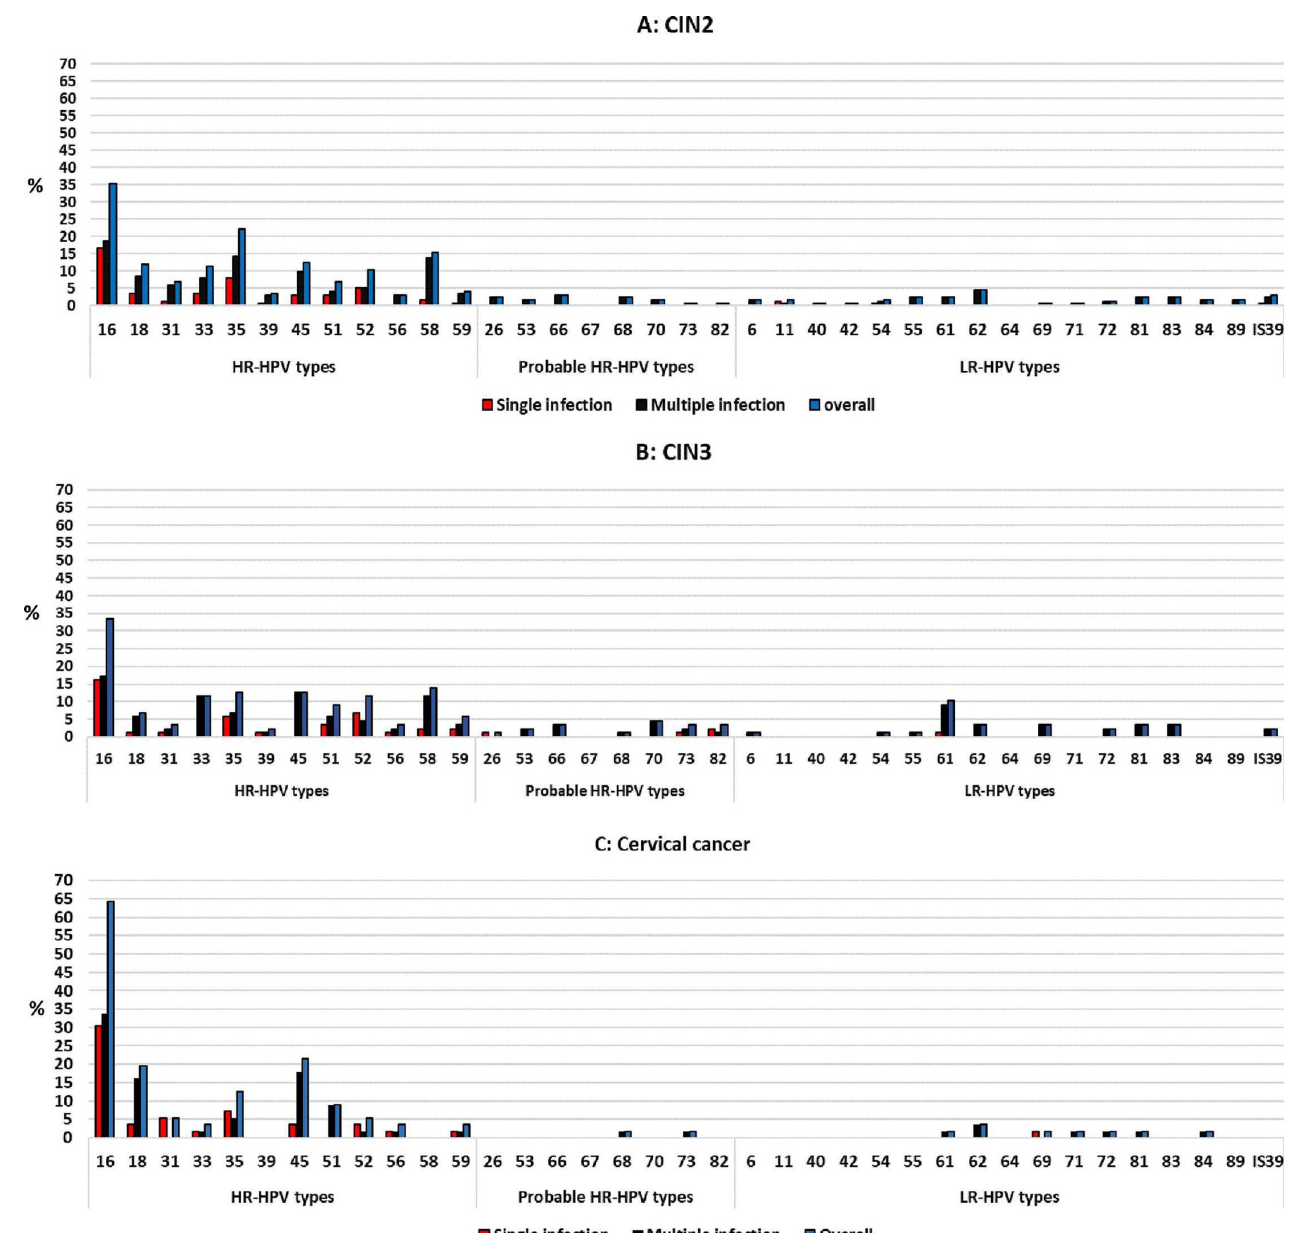
Fig 3. High–risk human papillomavirus genotype distribution among women with CIN2 (A), CIN3 (B) or cervical cancer (C) referred to Nelson Mandela Academic Hospital Gynaecology department, Eastern Cape Province according to cervical histology data.